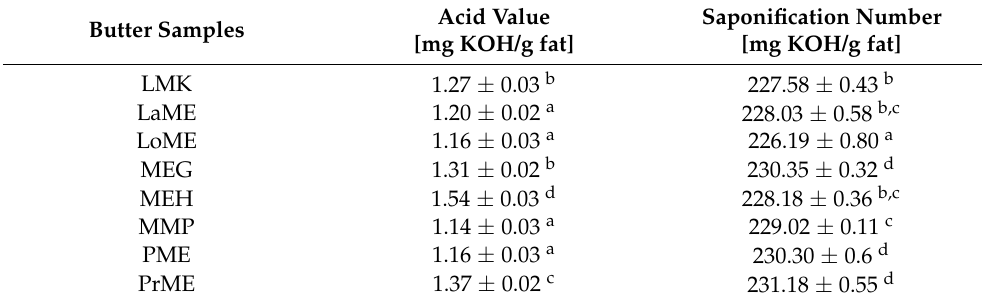
Table 7. Characteristics of butter milk fat. Butter